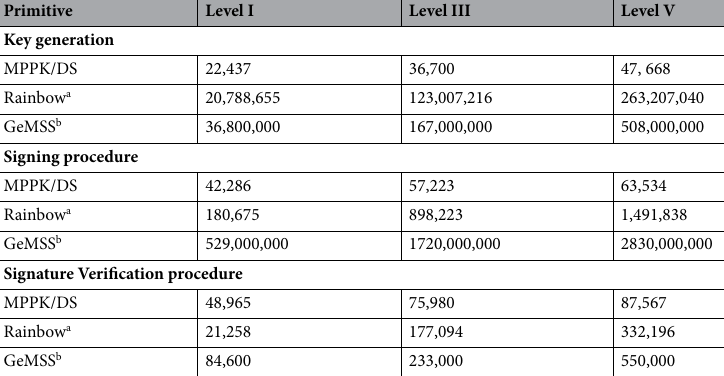
Primitive Level